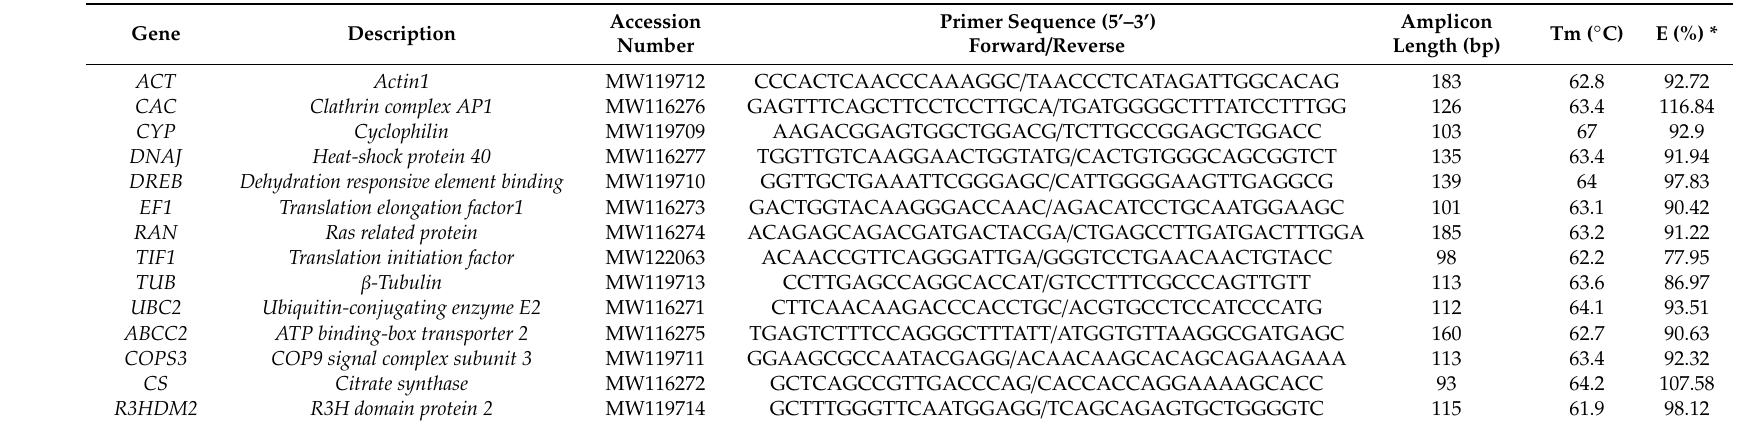
Table 2. Primers used in this